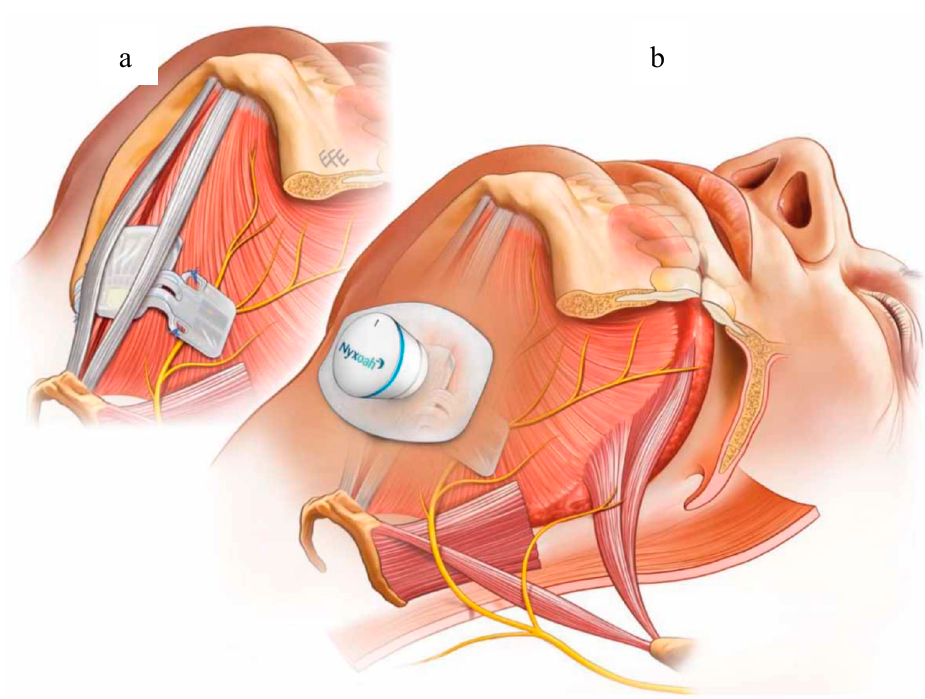
Figure 11. The Genio system. ( a ) The implanted stimulator straddling the genioglossus muscles and hypoglossal nerve branches bilaterally and ( b ) the disposable patch and activation unit. There were no device-related serious adverse events (SAE) six months post implant.